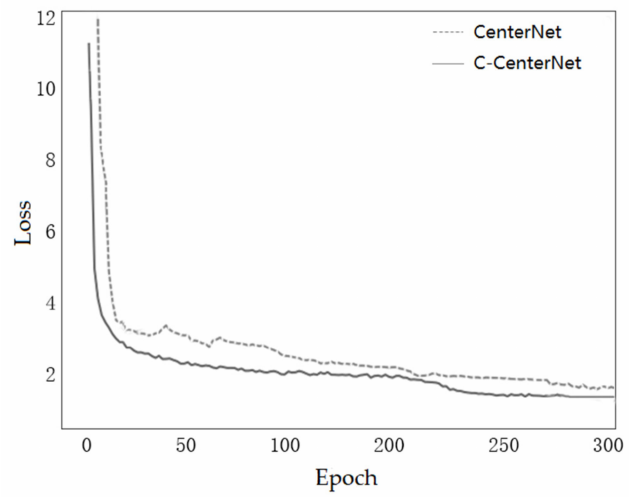
Figure 12. The training process loss